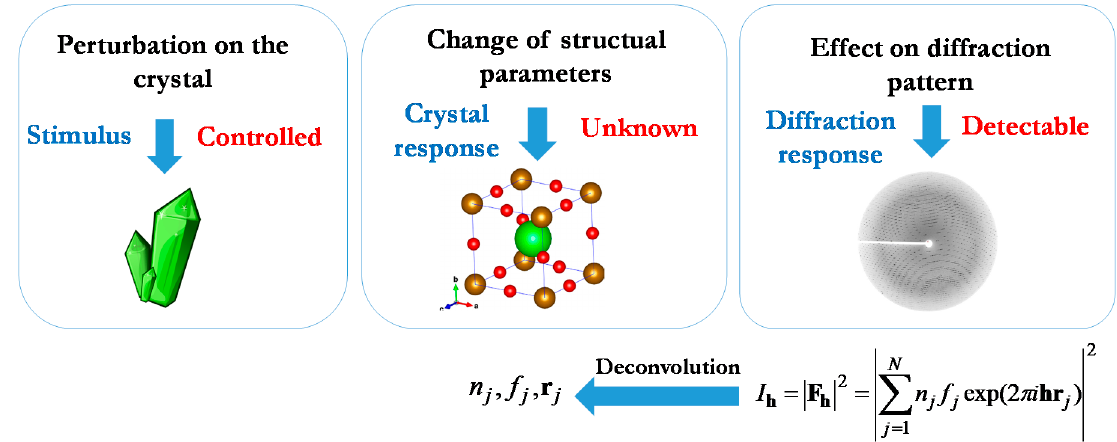
Figure 3. Main steps involved in a MED experiment. A perturbation is applied in a controlled way on a crystal sample, which responds by changing the crystal structural parameters in unknown way. Repeated X-ray diffraction measurements allow detecting the diffraction response, which can be properly analyzed through an offline process called deconvolution, to determine the variations in main structural parameters.